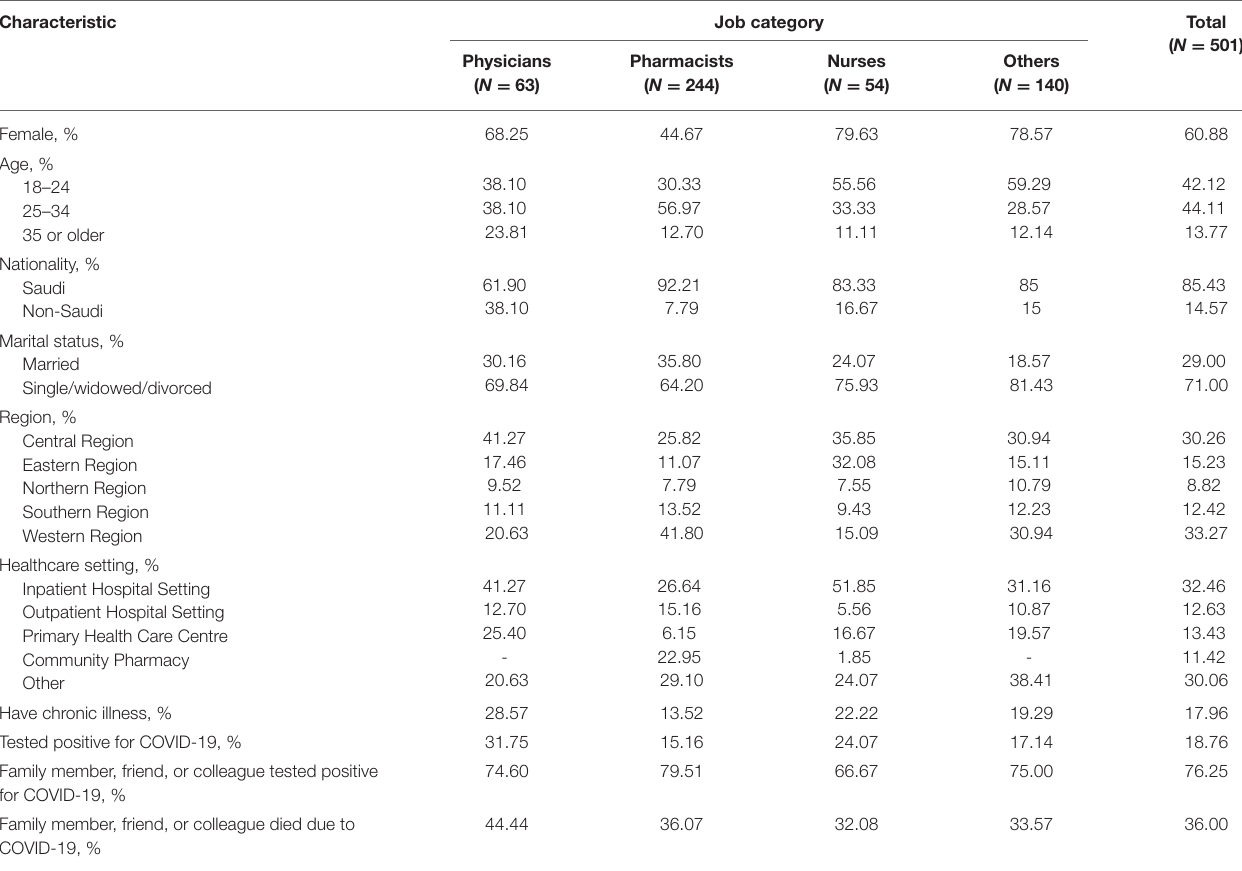
TABLE 1 | Sociodemographic characteristics of study participants.